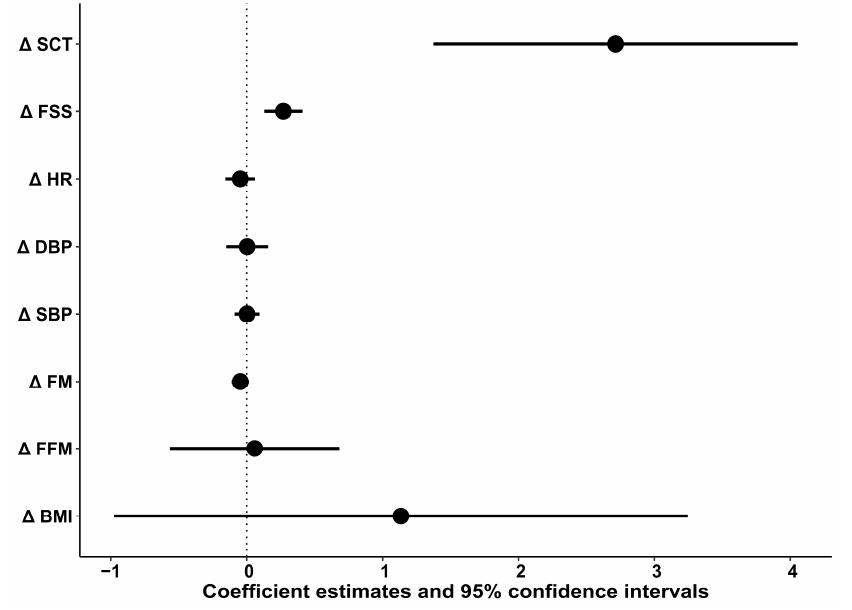
Figure 2. Associations between improvements in the parameters and reductions in ODI . Δ—changes between pre and post intervention; SCT—stair climb test; FSS—fatigue severity scale; HR—heart rate; DBP—diastolic blood pressure; SBP—systolic blood pressure; FM—fat mass; FFM—fat-free mass; BMI—body mass index .